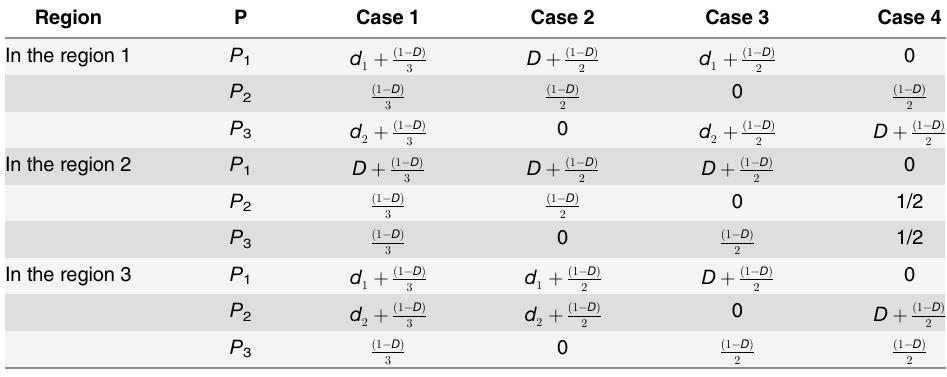
Table 1. The probabilities of the pedestrians choosing the east( P 1 ), north( P 2 ) and south( P 3 ) site in dif- ferent regions and cases. Region P Case 1 Case 2 Case 3 Case 4 In the region